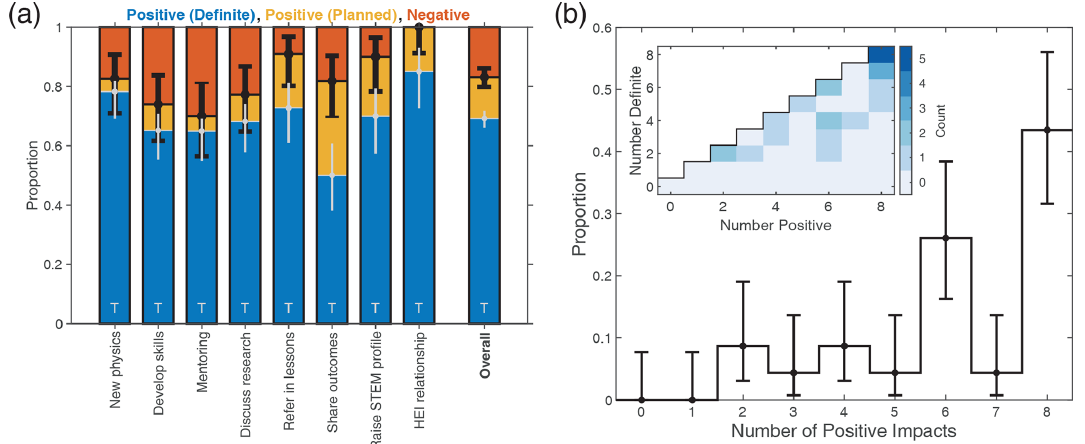
Figure 5. Quantitative results of impacts on teachers and schools ( n = 23). (a) Distribution of teachers’ responses for each impact category. Results are divided (black lines and associated error bars) into negative (red) and positive responses, with the latter subdivided (grey lines and error bars) into “definite” (blue) and “planned” (yellow). (b) Distribution of the number of positive impact categories reported per teacher, with the bivariate distribution of the number of definite impacts vs. positive ones shown inset. Error bars denote standard (1 σ ) Clopper and Pearson (1934)